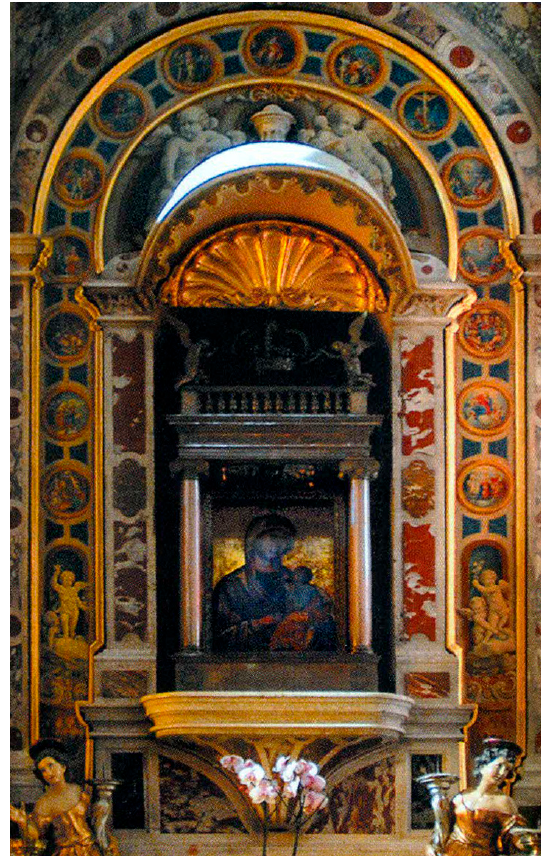
Figure 15. The Virgin Galaktotrophousa (Madonna of the Rosary), Makarska, Co-Cathedral of Saint Mark